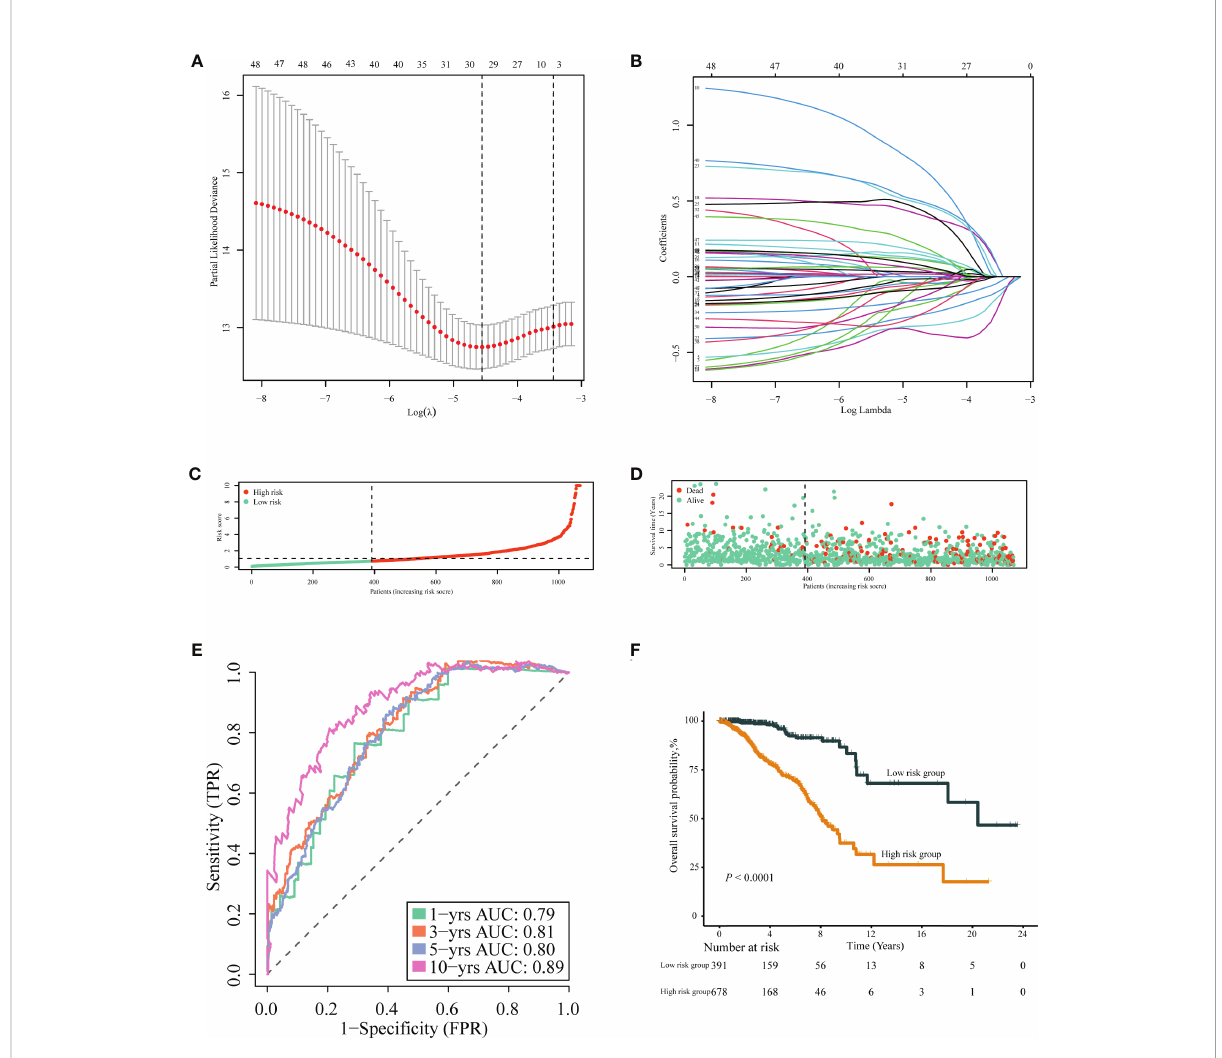
FIGURE 4 Construction of TIIS. (A, B) LASSO Cox regression of differentially expressed immune- or in fl ammation-related genes in the TCGA-BRCA training cohort. The risk curve of the distribution of patients ’ prognostic score (C) , survival time, and status (D) . Time-dependent ROC curves (E) for survival probability of TIIS. Kaplan – Meier curves (F) for 1,069 patients classi fi ed as high and low risk by TIIS. LASSO, least absolute shrinkage and selection operator; ROC, receiver operating characteristic. TIIS, tumor immune-in fl ammation